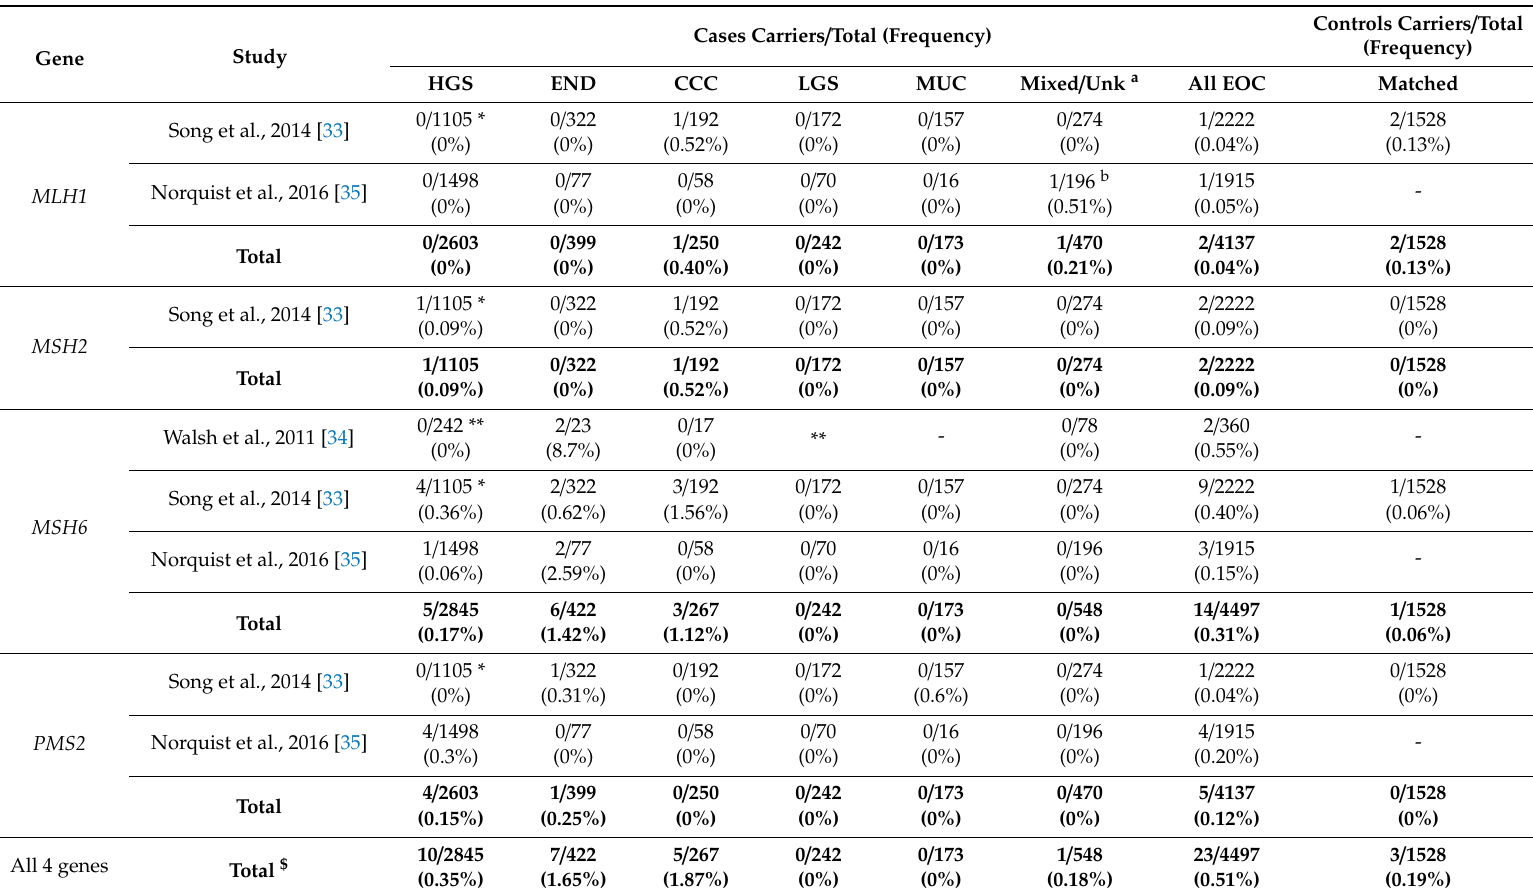
Table 4. Frequency of germline pathogenic variants in the mismatch repair (MMR) genes in EOC histotypes, in cases from population